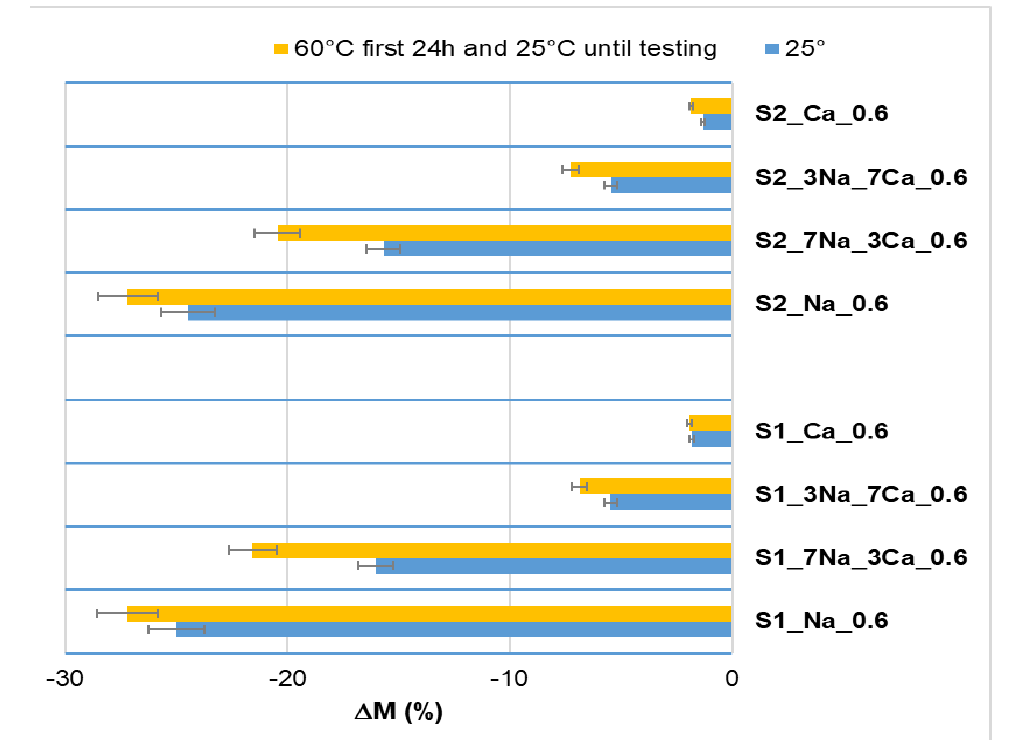
Figure 9. The mass loss of G-AAIPs obtained from glass powders with different fineness (S1—2086 cm 2 /g and S2—2998 cm 2 /g) after immersion in distilled water for 90 days.